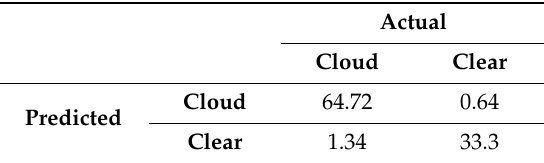
Table 5. Confusion matrix for ARGD.